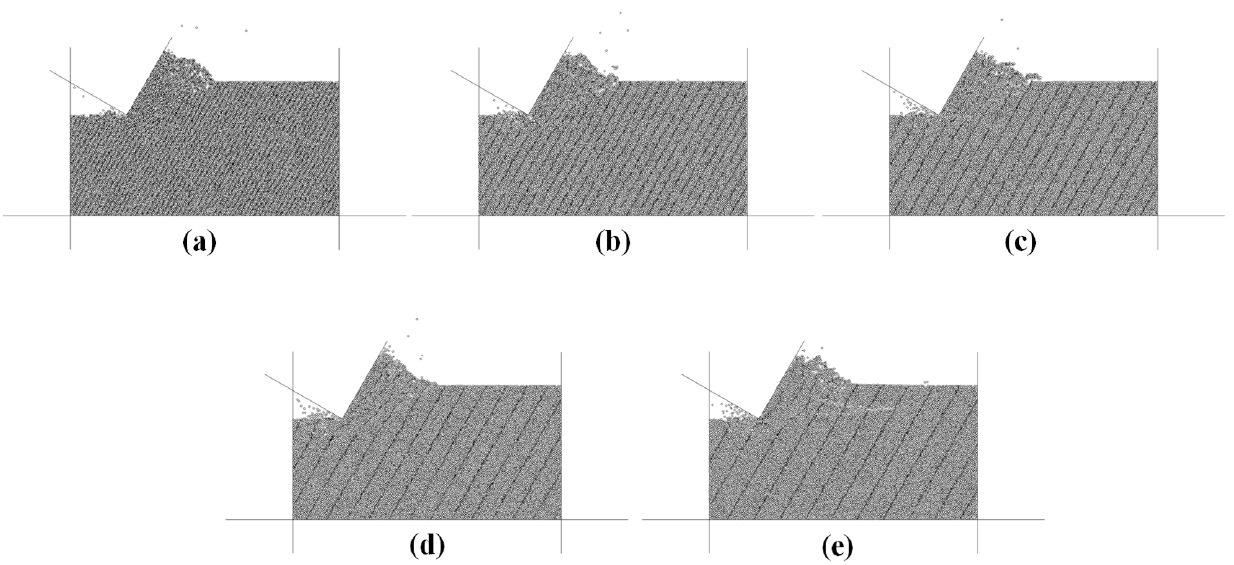
Figure 10. Cutting failure of numerical specimens with different bedding thicknesses: ( a ) 2 mm; ( b ) 4 mm; ( c ) 6 mm; ( d ) 8 mm; ( e ) 10 mm.